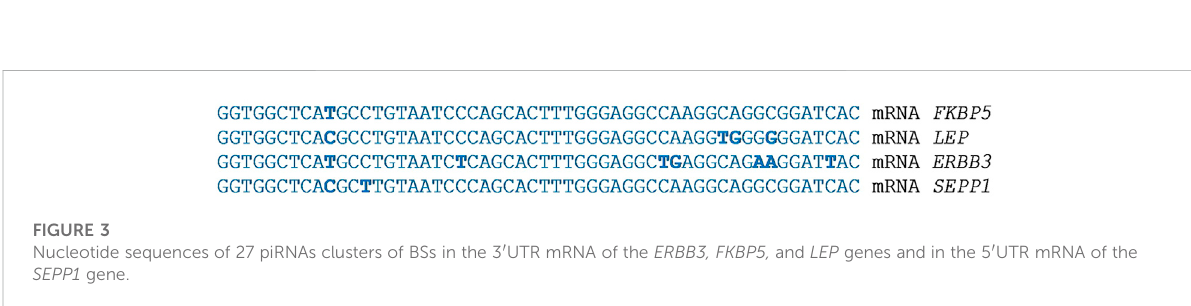
FIGURE 3 Nucleotide sequences of 27 piRNAs clusters of BSs in the 3 ′ UTR mRNA of the ERBB3, FKBP5, and LEP genes and in the 5 ′ UTR mRNA of the SEPP1